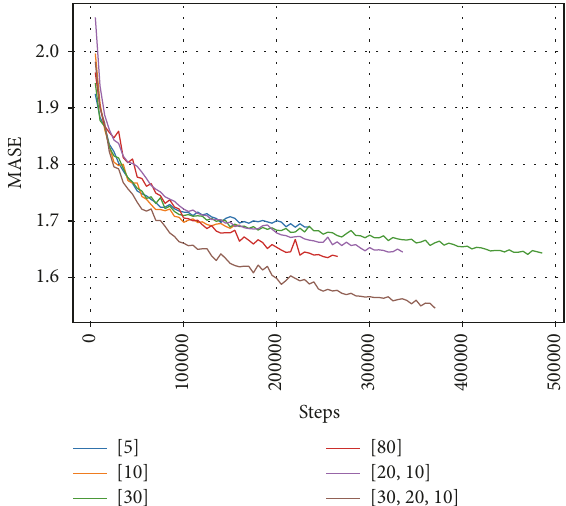
Figure 6: Trend in MASE for different FNNs with SELU activation function.